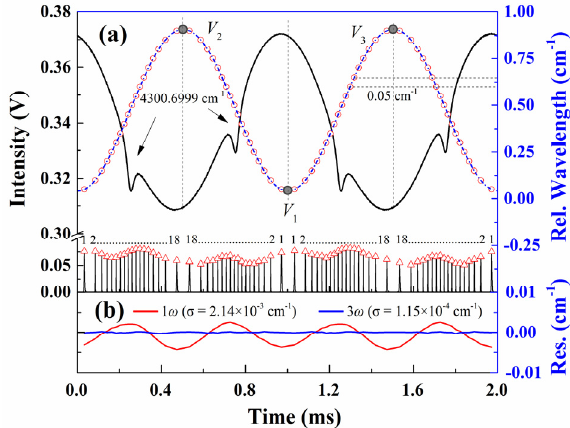
Figure 2. ( a ) Detected transmitted light intensity and etalon fringe peak results together with the best fit of the relative wavelength. ( b ) Fitting residuals of the best-fit relative wavelength. The experimental conditions are: CO/N 2 mixture gas, T = 299 K, L = 14.7 cm, Xco = 1.02%, P = 101.3 kPa.